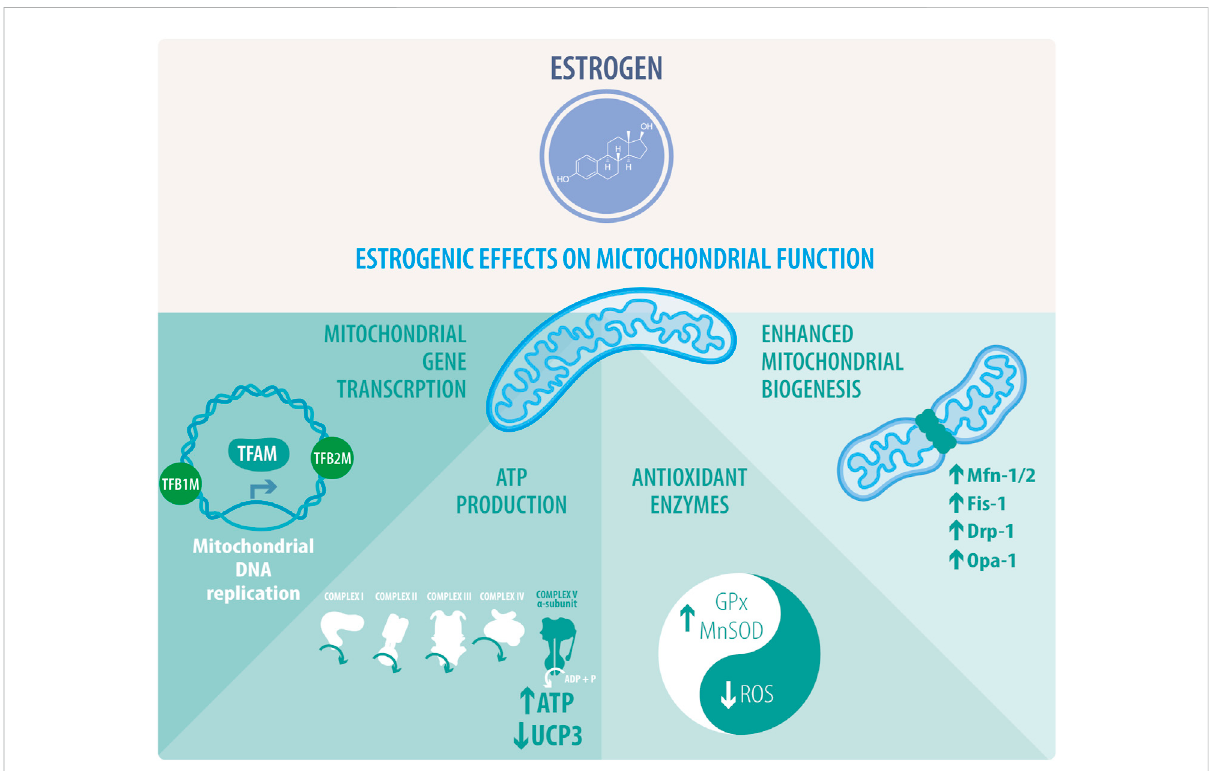
FIGURE 2 Estrogenic effects on mitochondrial function. Estrogens or activation of estrogenic pathways activate the transcription of mitochondrial genes andthereplicationofmitochondrialDNAthankstothestimulationofthetranscriptionfactorsTFAM,TFB1M,andTFB2M.Thisactivitycorrelateswith enhanced mitochondrial biogenesis and regulation of mitochondrial dynamics. Estrogens mostly favor mitochondrial fusion by increasing the expression of FIS1, MFN1/2, and OPA1. Interestingly, the rise of DRP1 activity is directly related to mitochondrial fragmentation. Estrogenic activity directly impacts ATP synthesis through oxidative phosphorylation (OXPHOS), coupled to the mitochondrial respiratory chain. This effect is relatedtoanincreaseincomplexValphasubunit,subunit1,mitochondrialrespiration,anddownregulationofuncouplingprotein3(UCP3).Estrogen also preserves mitochondrial activity and integrity through the stimulation of the antioxidant enzymes glutathione peroxidase (GPx) and superoxide dismutase (SOD), leading to a decrease in reactive oxygen species